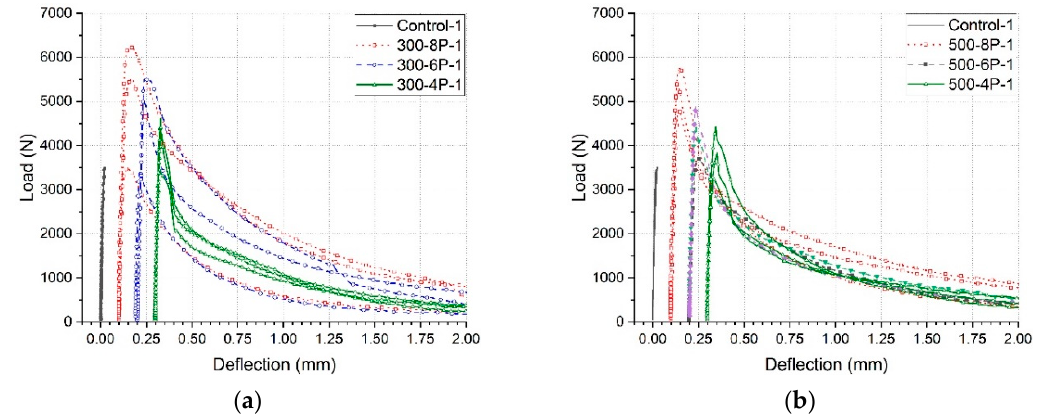
Figure 7. Bending test results of mixtures with 4 V%, 6 V% and 8 V% of ( a ) 300 μ m fibers and ( b ) 500 μ m fibers